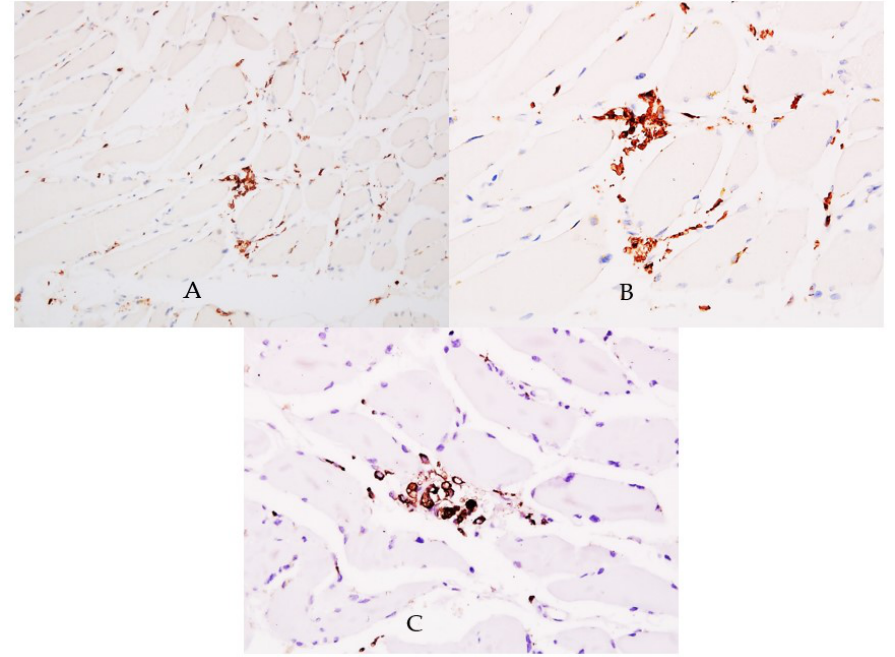
Figure 4. CD45 reaction. ( A ) Lymphocytes within muscle interstitium are highlighted by CD45 posi- tive reaction, × 200. ( B ) High-power view of the interstitial lymphocytic infiltrate, positive for CD45, × 400. ( C ) Aggregates of macrophages positive for CD68 were noticed within the skeletal muscle interstitium, × 400.